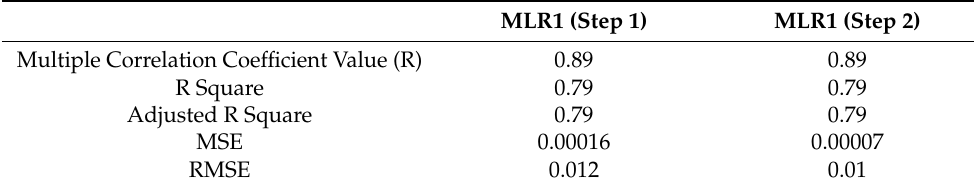
Table 6. MLR1 regression statistics and performance metrics.